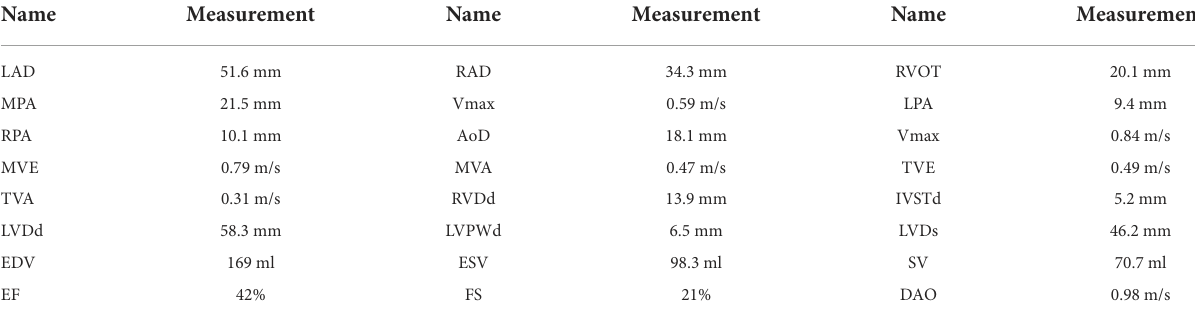
TABLE 1 Measurement data of echocardiography.